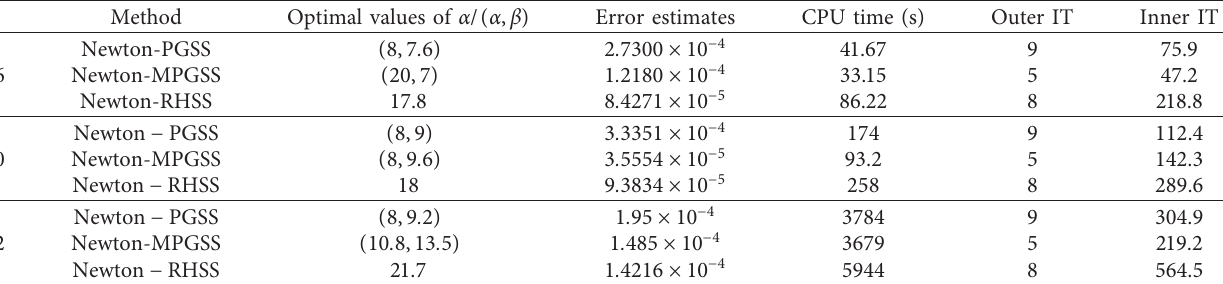
Table 4: Numerical results of inexact methods for v � 1 and η �